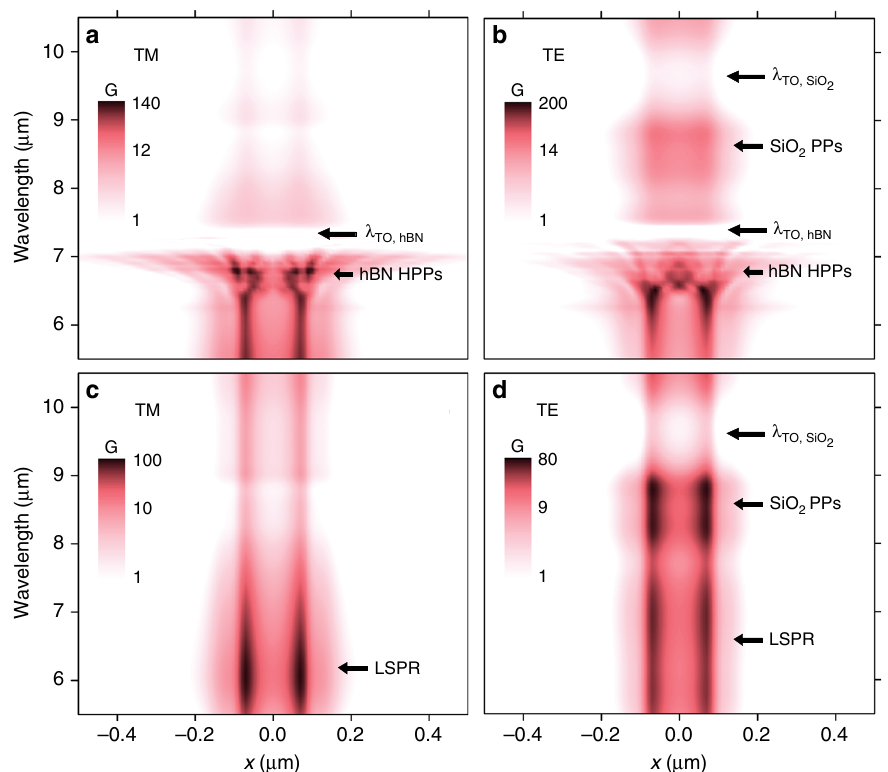
Fig. 3 Absorption enhancement spectra. Simulations of the absorption enhancement in graphene ( G ) along the source-drain direction ( x direction as shown in Fig. 1a, b, where x = 0 is located at the center of the gate gap) as a function of the wavelength, for TM ( a ) and TE-polarization ( b ). ( c ) and ( d ) correspond to ( a ) and ( b ), respectively, but with wavelength-independent refractive index for hBN ( n =